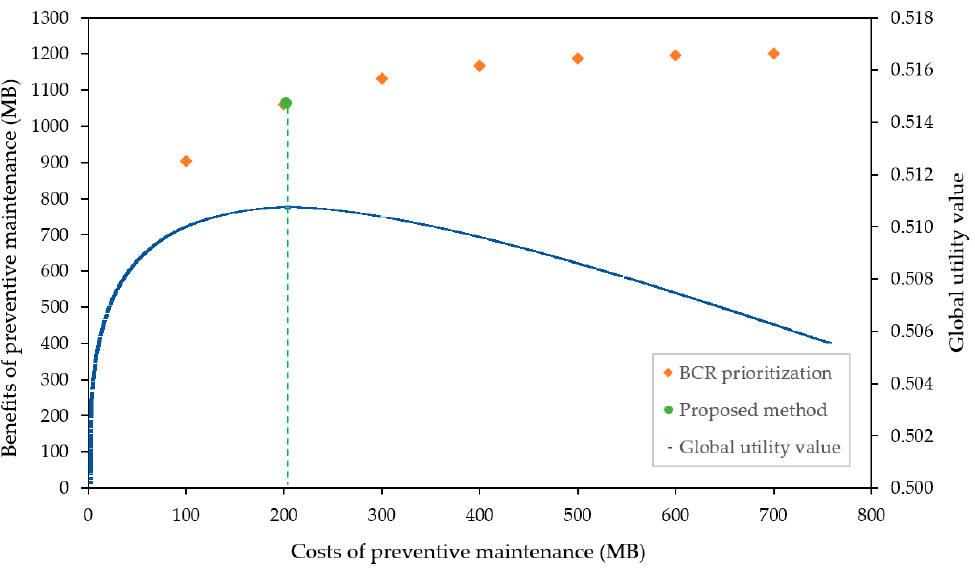
Figure 6. The benefits and costs of preventive maintenance plans. Table 8. Comparisons of results between BCR prioritization and the proposed method.